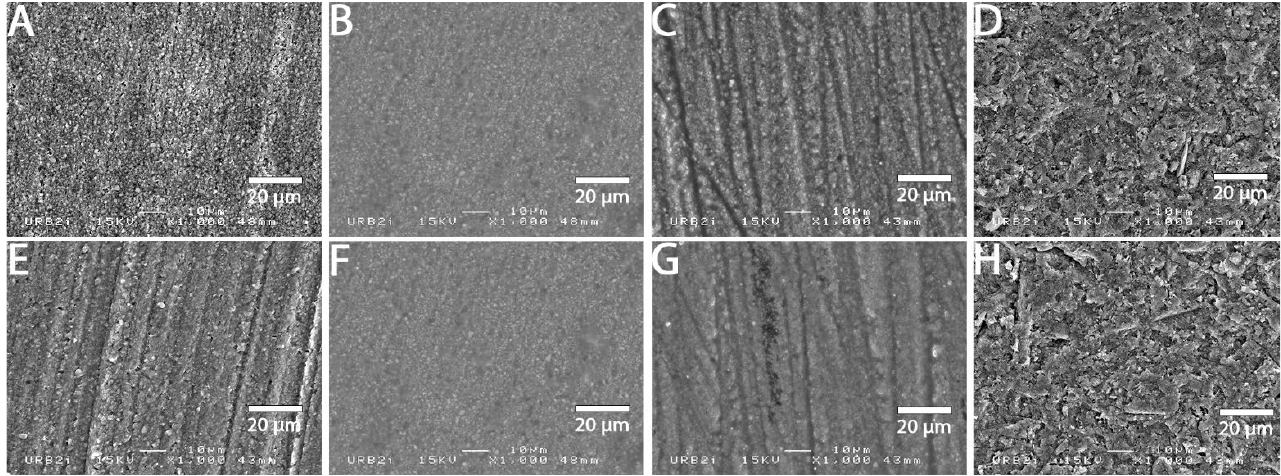
Figure 7. SEM micrograph for Tetric CAD surface (×1000 magnification) with the different surface treatments: ( A ) control; ( B ) polyacrylic acid; ( C ) hydrofluoric acid; ( D ) sandblasting; ( E ) 800 grit polishing + universal primer; ( F ) polyacrylic acid + universal primer; ( G ) hydrofluoric acid + universal primer; ( H ) sandblasting + universal primer. Sandblasting surface treatment ( D , H ) shows a more irregular pattern surface than the other ones.